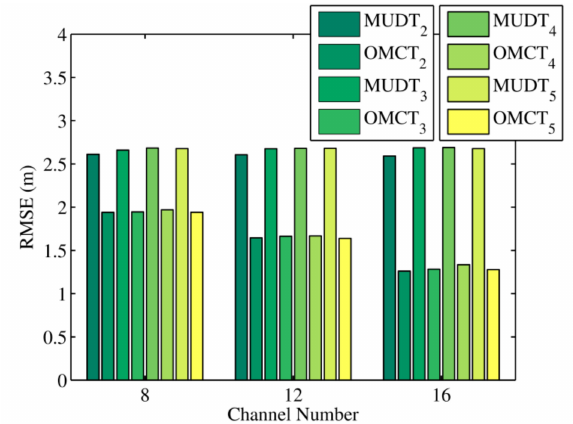
Figure 6. The RMSEs of MUDT and OMCT under di ff erent channel numbers in the